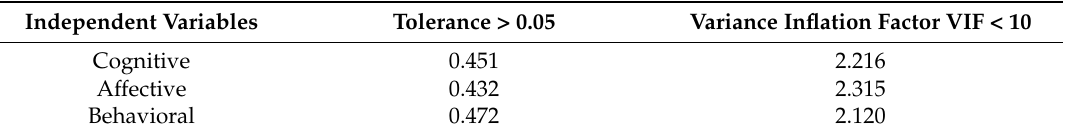
Table 5. Multicollinearity test of independent